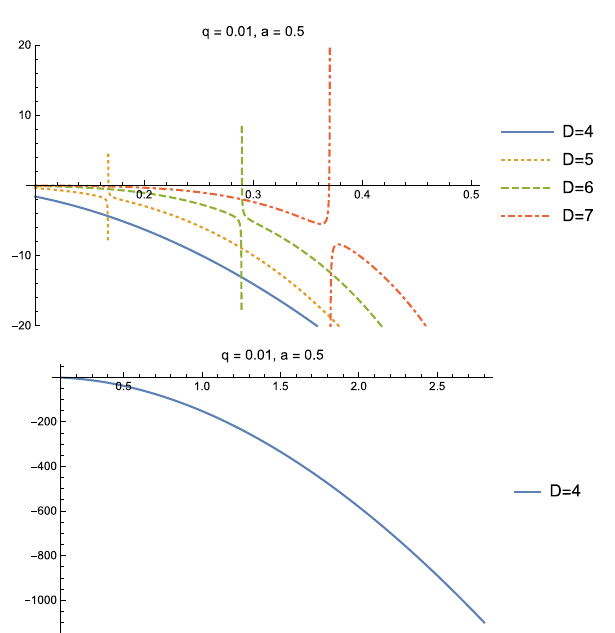
Fig. 10 The heat capacity in D-dimensional TGR as function of r h for different values of q